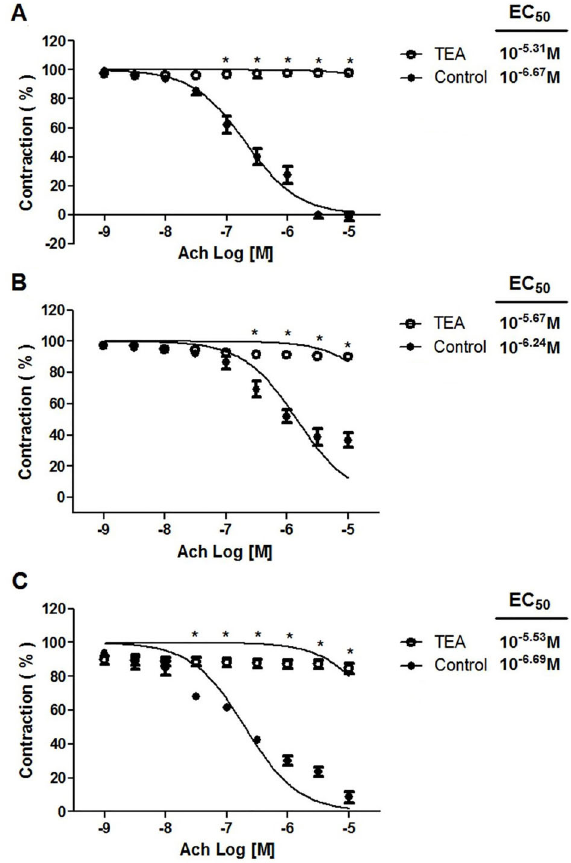
Figure 5. Effect of tetraethylammonium (TEA, 10 – 2 M) on acetylcholine (Ach) relaxation of endothelium-intact rat aortic rings precontracted with 10 – 6 M phenylephrine. The rings